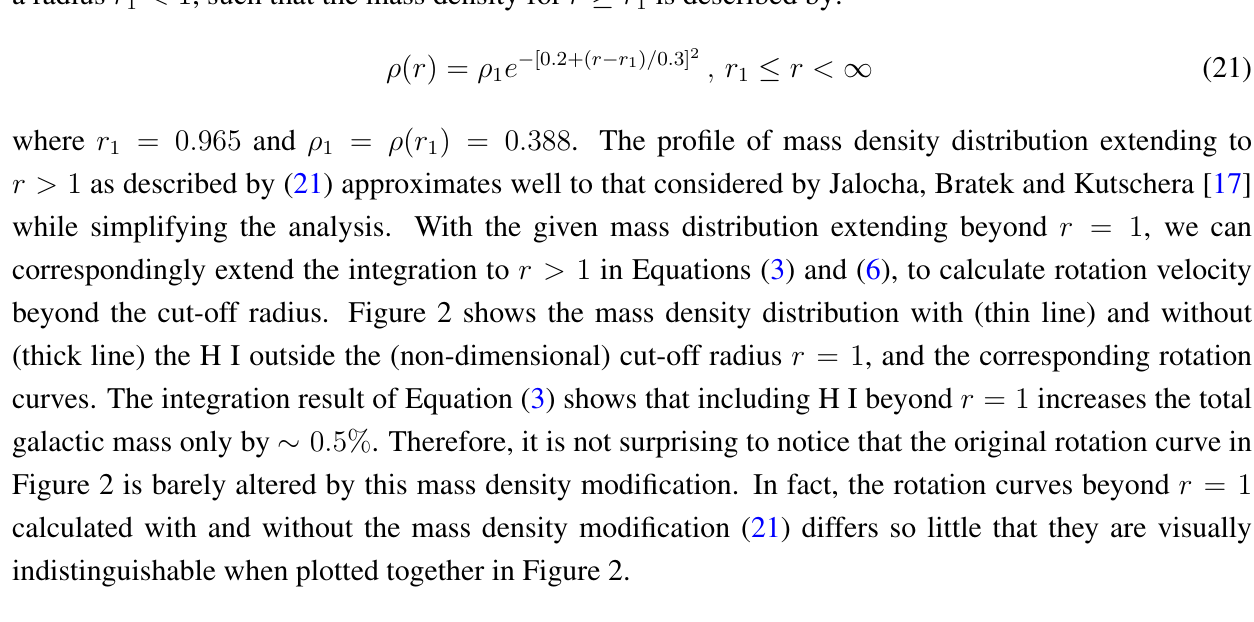
Figure 2. The distributions of mass density ρ ( r ) with (thin line) or without (thick line) H I extending beyond the cut-off radius, and the corresponding rotation curves. Only the case based on the THINGS rotation curve is shown